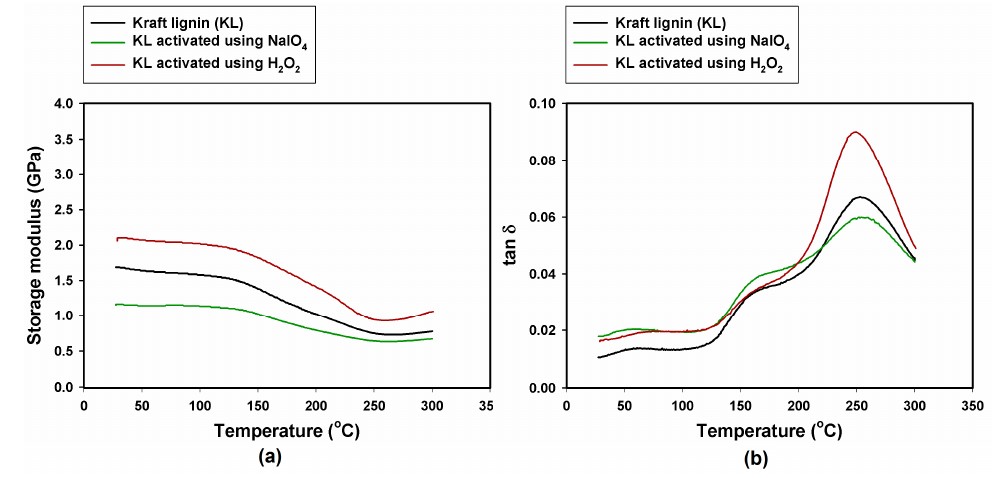
Figure 7. Mechanical-thermal properties of composites with kraft lignin: ( a ) storage modulus; and ( b ) loss factor.